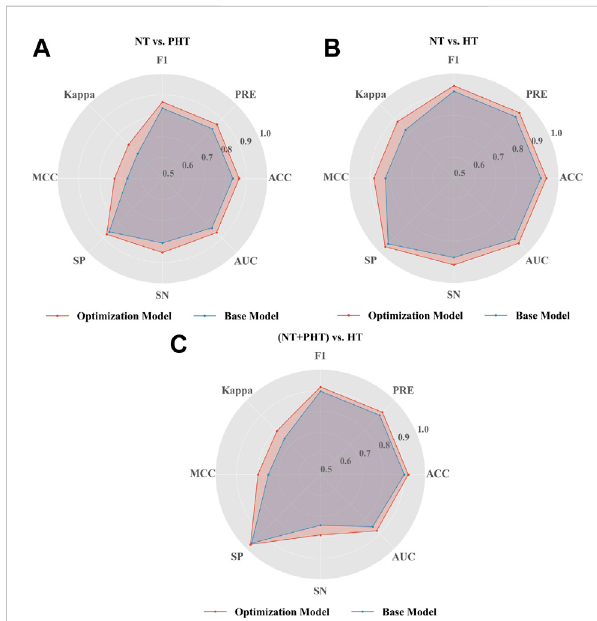
FIGURE 4 Performance of LightGBM in the classi fi cation of hypertension. Radar plot illustrations the performance of base and optimization LightGBM model in (A) NT vs. PHT (B) NT vs. HT and (C) (NT + PHT) vs. HT. Note, NT, PHT, and HT refer to normotension, prehypertension, and hypertension, respectively. SP stands for speci fi city, SN stands for sensitivity, ACC stands for accuracy, PRE standsforprecision,MCCstandsforMatthew ’ scorrelationcoef fi cient, Kappa stands for Cohen ’ s kappa coef fi cient, AUC stands for Area under